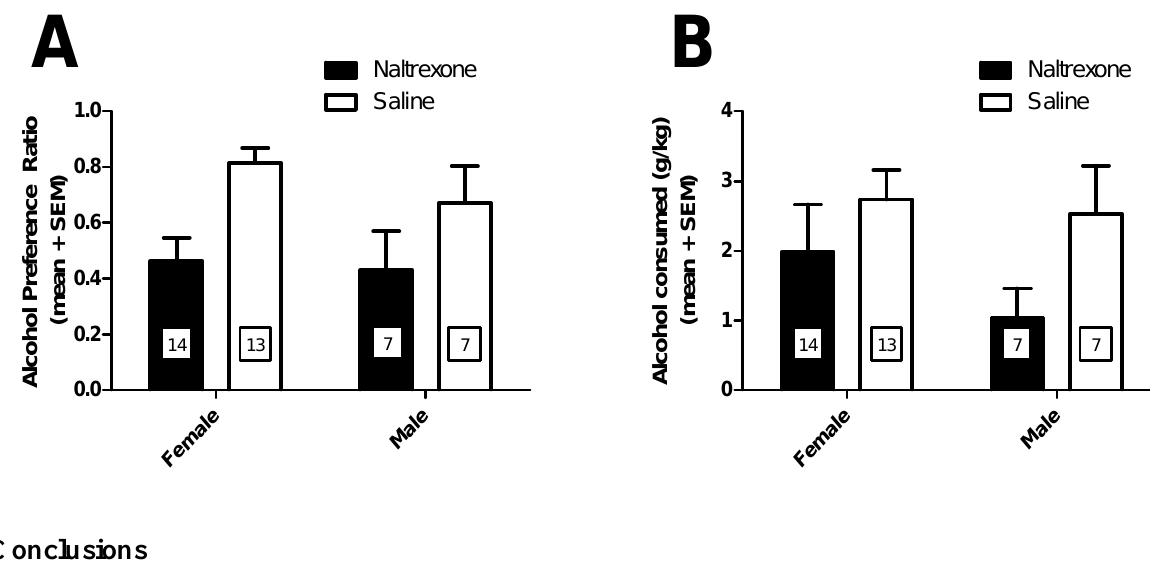
Figure 1. (a) Alcohol preference ratio and (b) alcohol dose consumed by female and male prairie voles administered saline or naltrexone (8 mg/kg) in a two-hour limited access procedure. The number of animals per group is noted within each